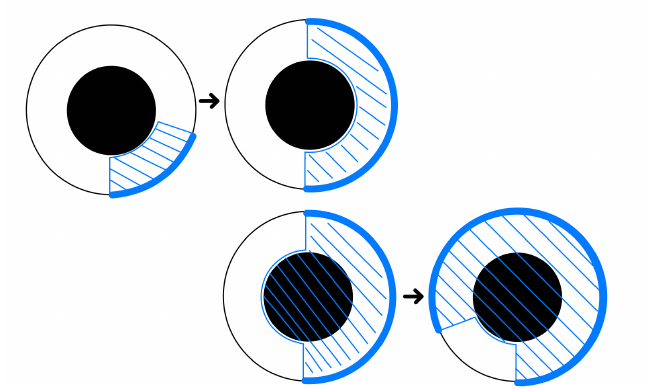
Figure 6 . The phase transition of the RT surface as a function of ϕ . The outer circle is the boundary spatial slice τ = 0 . The black solid circle is the BTZ black hole (it’s boundary is the horizon). The upper row include the first ‘thermal’ RT surface (thin blue line) changes as a function of ϕ . The middle column describe the phase transition at ϕ = π to the new solution on the bottom row. Together the two solutions give a Page-like behavior for the holographic S vN ( ϕ ) (see figure